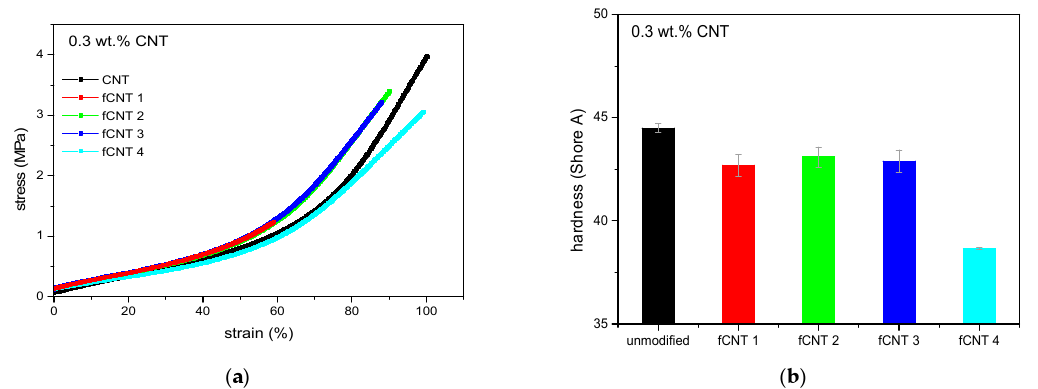
Figure 14. Mechanical properties depending on the functionalization method ( a ) stress–strain behavior and ( b ) Shore A hardness.